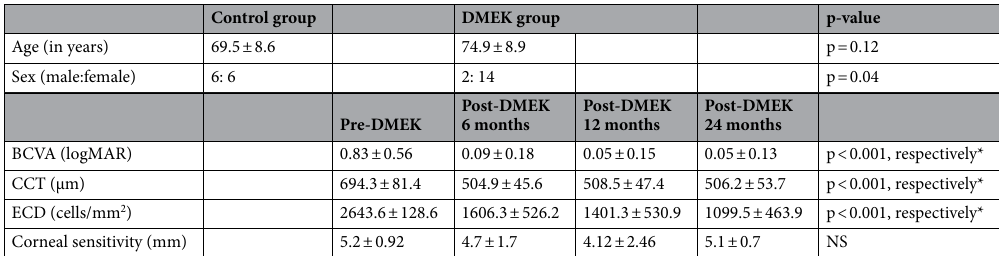
Table 1. Patient characteristics. DMEK Descemet’s membrane endothelial keratoplasty, BCVA best-corrected visual acuity, CCT central corneal thickness, ECD endothelial cell density, NS not significant. *Significant difference compared to pre-DMEK (p < 0.05) followed by Kruskal–Wallis rank sum test. Values are expressed as mean ± standard